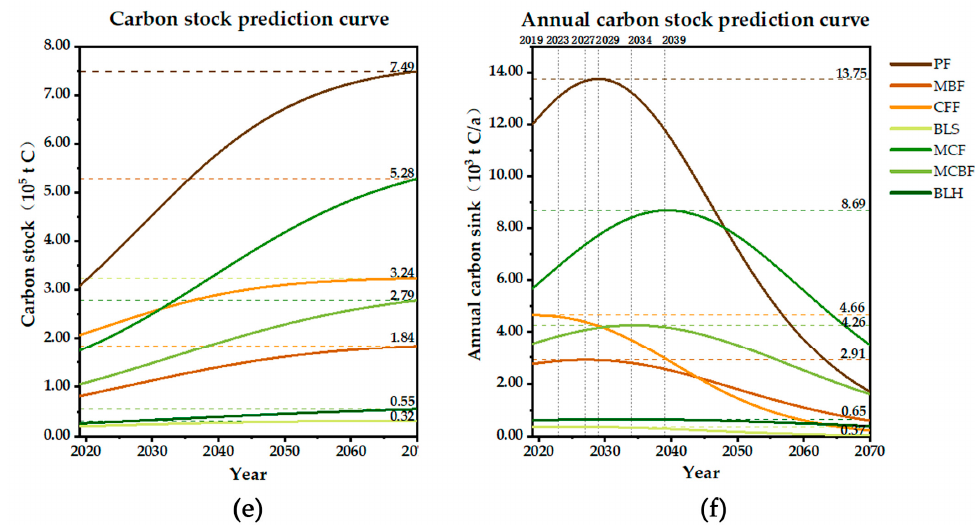
Figure 5. Carbon sequestration potential of different forest types in Lushan City from 2019–2070: ( a ) depicts the change of carbon stock of forest types in Lushan, ( b ) records the contribution of different forest types to the total carbon stock more visually in percentage; ( c ) depicts the change of annual carbon sink of forests types in Lushan; and the contribution of different forest types to the total annual carbon sink is visually represented in ( d ); ( e ) compares the change of carbon stock of different forest types, and ( f ) compares the annual carbon sink changes of different forest types and records the peak and arrival years.